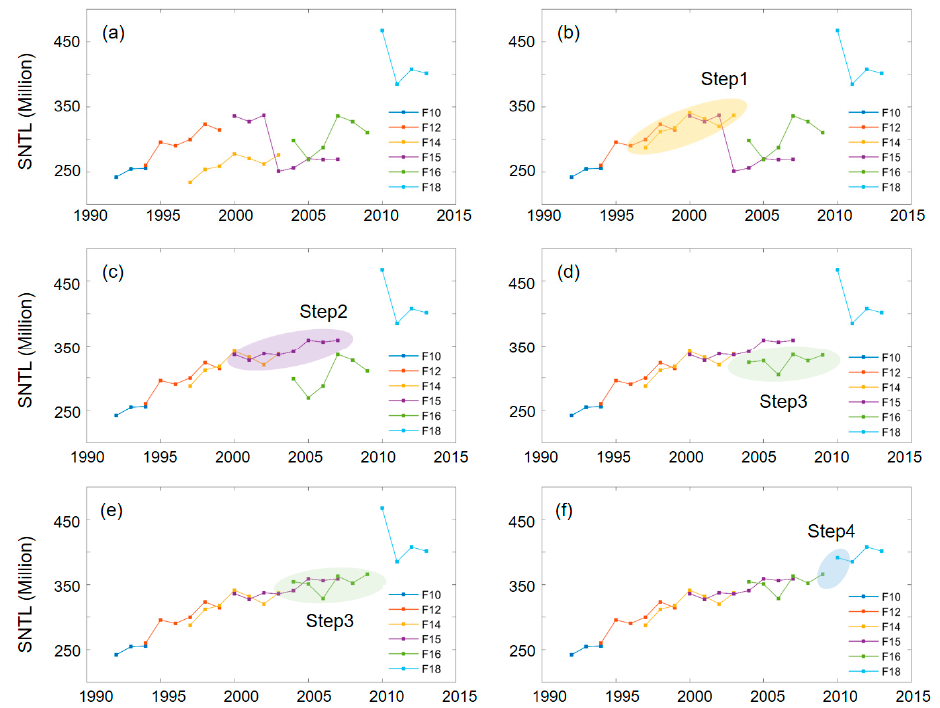
Figure 6. The sum of nighttime light (SNTL) of stable NTL time series in the stepwise calibration: ( a ) raw NTL time series; ( b ) step 1: systematic adjustment of F14; ( c ) step 2: period-based adjustment of F15; ( d ) step 3a: calibration of F16; ( e ) step 3b: systematic adjustment of calibrated F16; and ( f ) step 4: adjustment of F182010. The shaded ellipses are calibrated NTL data in each step.